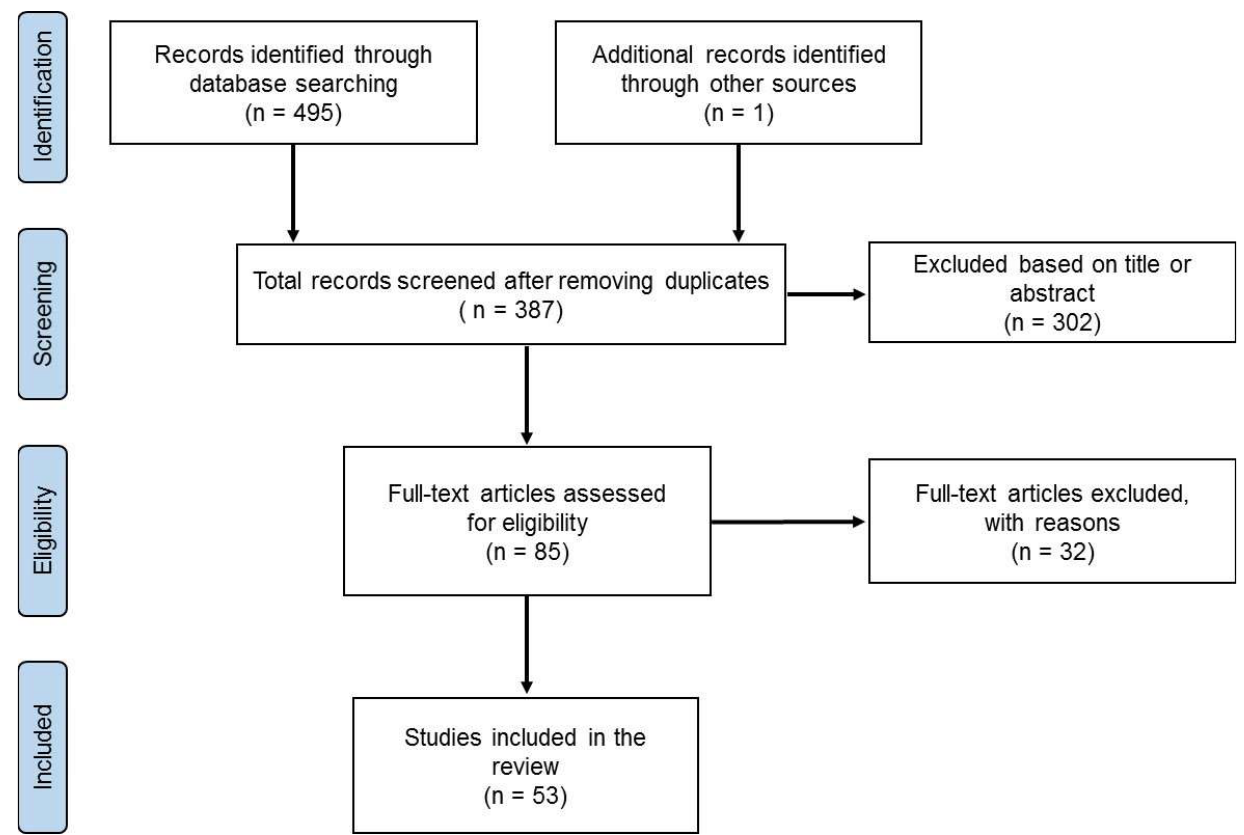
Figure 1. Flow diagram of search process.